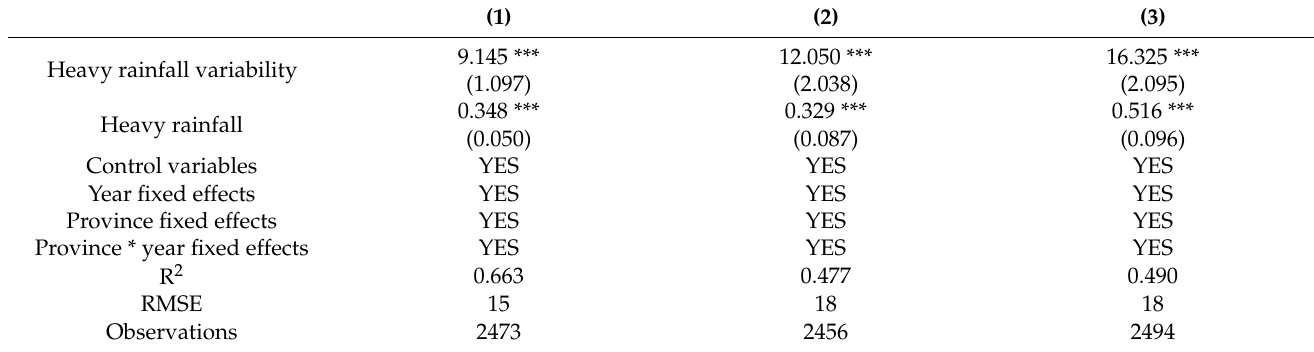
Table 4. Robustness checks using alternative